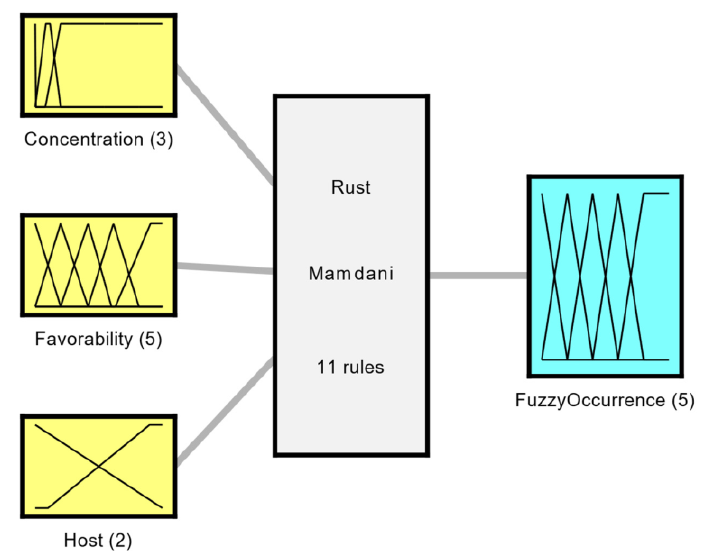
Figure 1. Organization chart with the input and output variables of the Fuzzy Rust